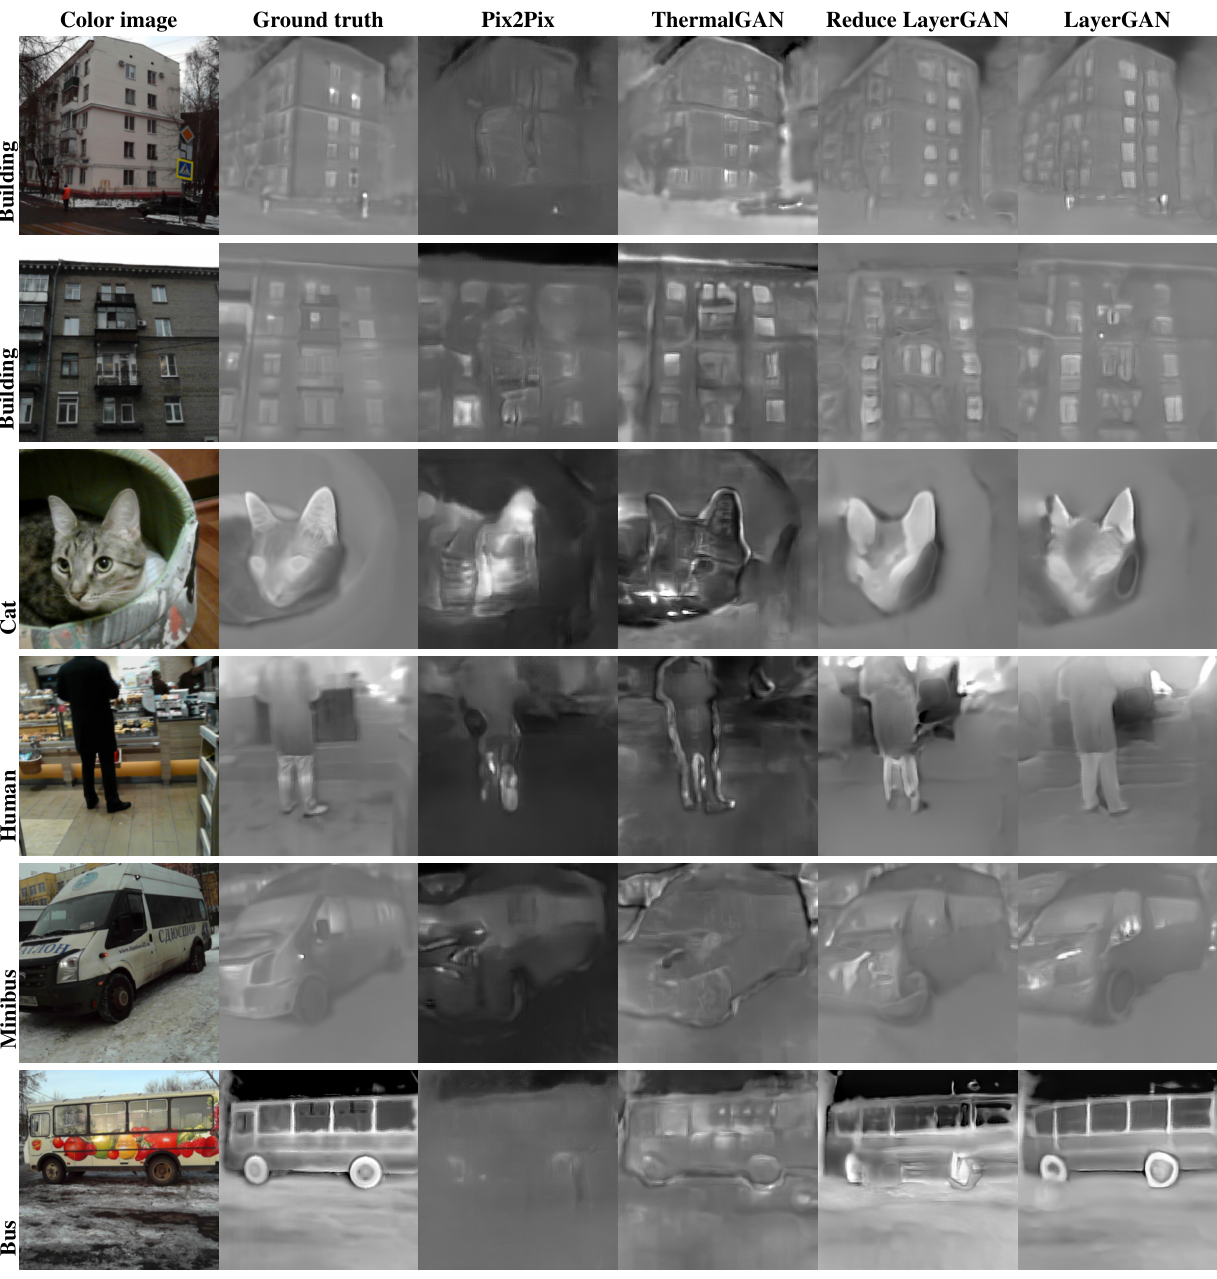
Figure 5. The Qualitative evaluation different